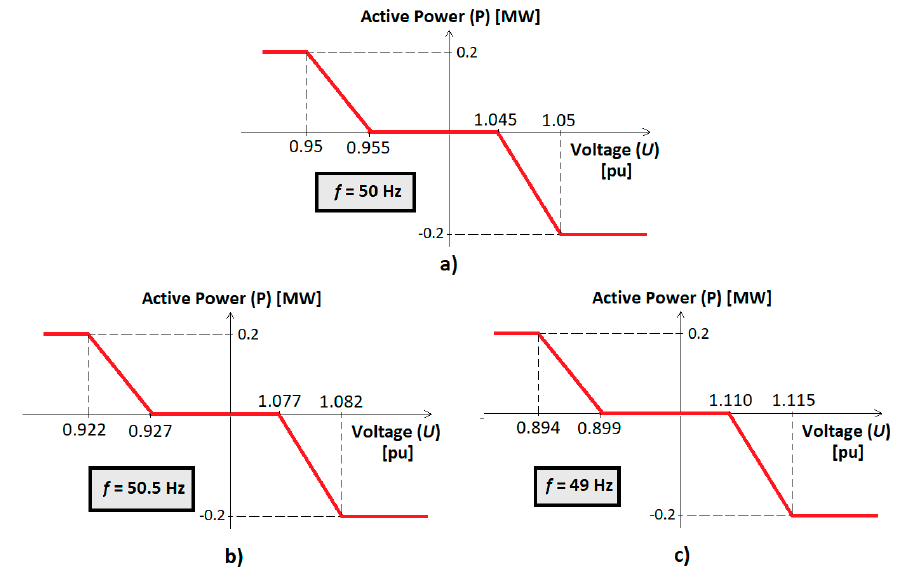
Figure 10. Example of real-time frequency adaptive PU -droop values for 200 kW BESS with ( a ) f = 50 Hz, ( b ) f = 50.5 Hz, and ( c ) f = 49 Hz ( f n = 50 Hz, P n = 0.2 MW, U min_ini = 0.955 pu, and U max_ini = 1.045 pu, Figure